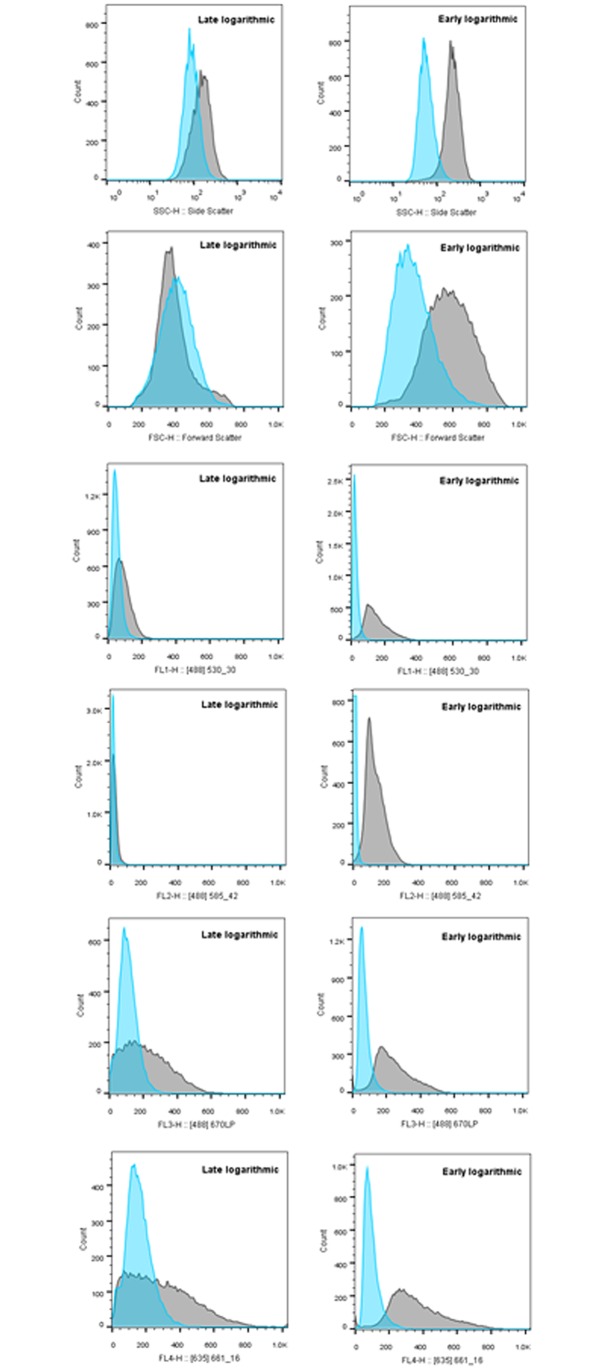
Overlay of vegetative and gametic distribution in early and late logarithmic growths.Dark Grey = vegetative cultures. Light Grey = gametic. Lower levels of overlap are seen in early logarithmic cultures compared to late logarithmic cultures. Side-scatter (SSC), FL1 and FL2 in particular show separation of the two populations.